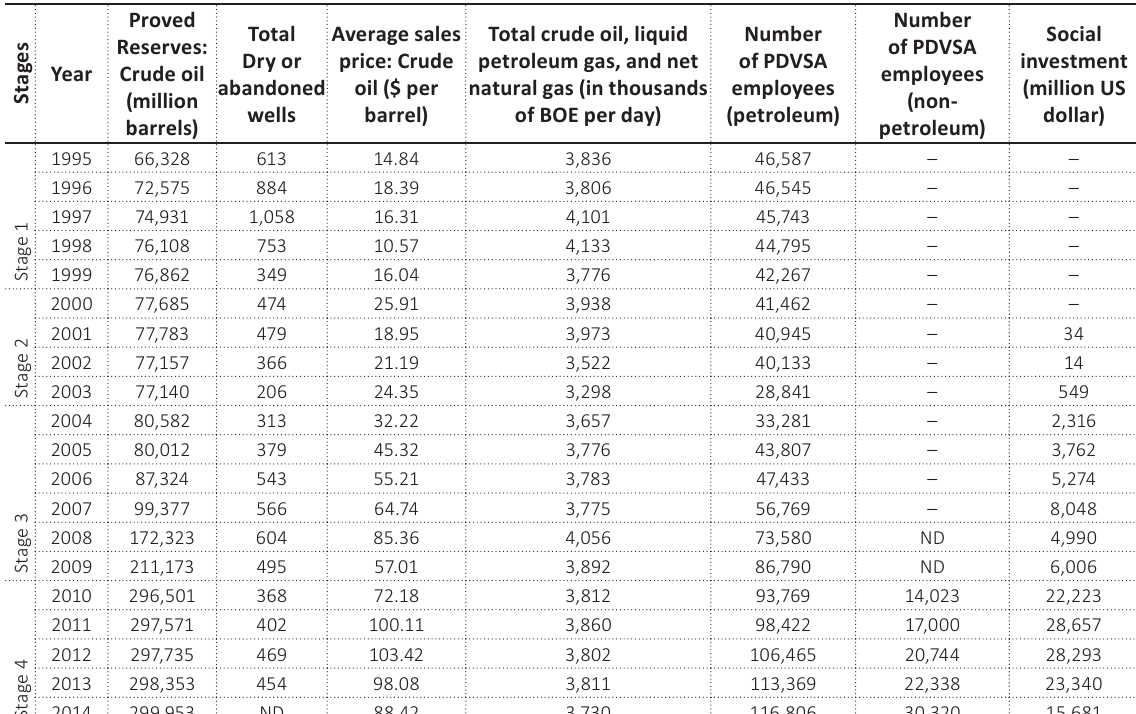
Table 2. PDVSA operation data by